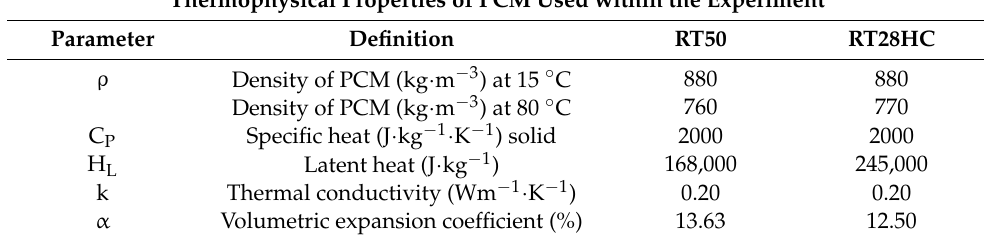
Table 1. Technical data for PCM (source: Rubitherm ®® data sheet).